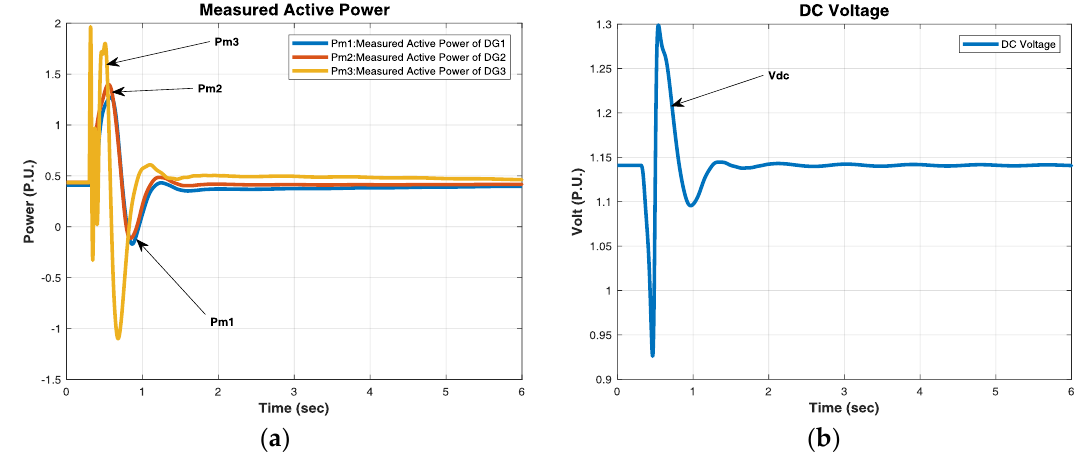
Figure 8. Microgrid response when a three-phase fault occurred at line 2.